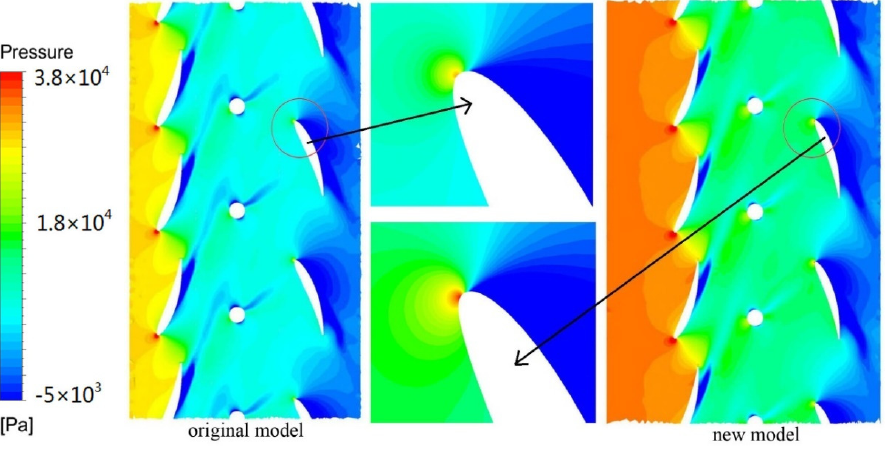
Figure 13. Pressure distributions of the original model and new model in their each highest efficiency.